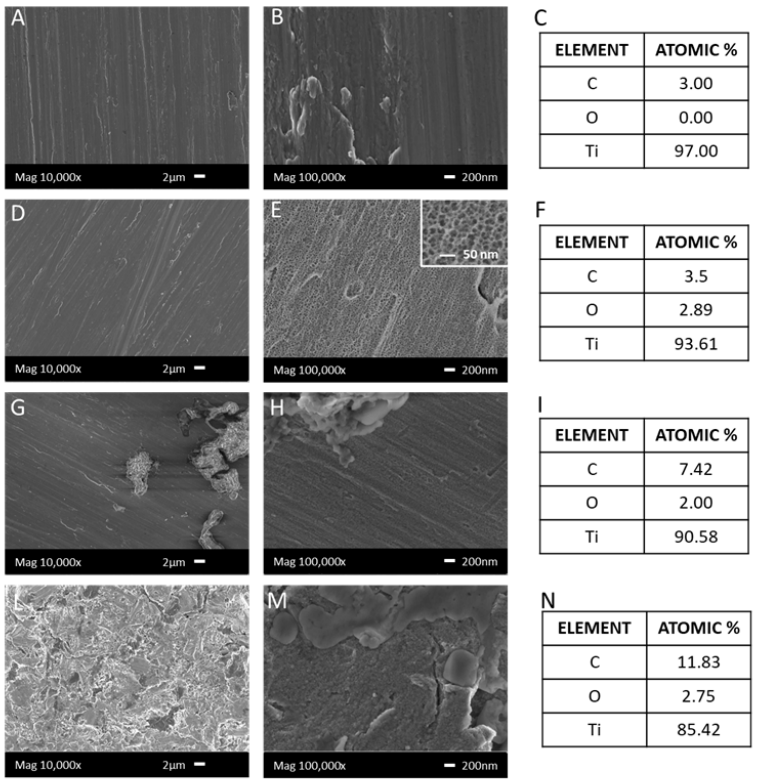
Figure 2. FESEM micrographs and EDS analyses of Ti-MP ( A – C ), Ti-Nano ( D – F ), Ti-Nano/P_Ca ( G – I ), and Ti-Nano/P_HP1 ( L – N ), showing the morphology and composition of the surfaces.